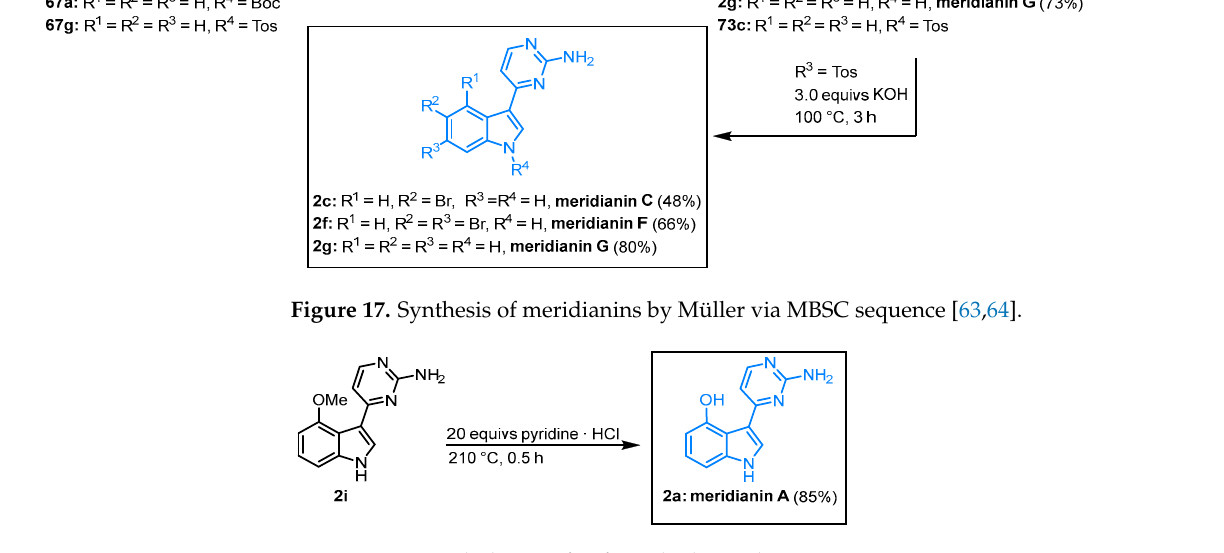
Figure 18. Demethylation of 2i furnished meridianin A.